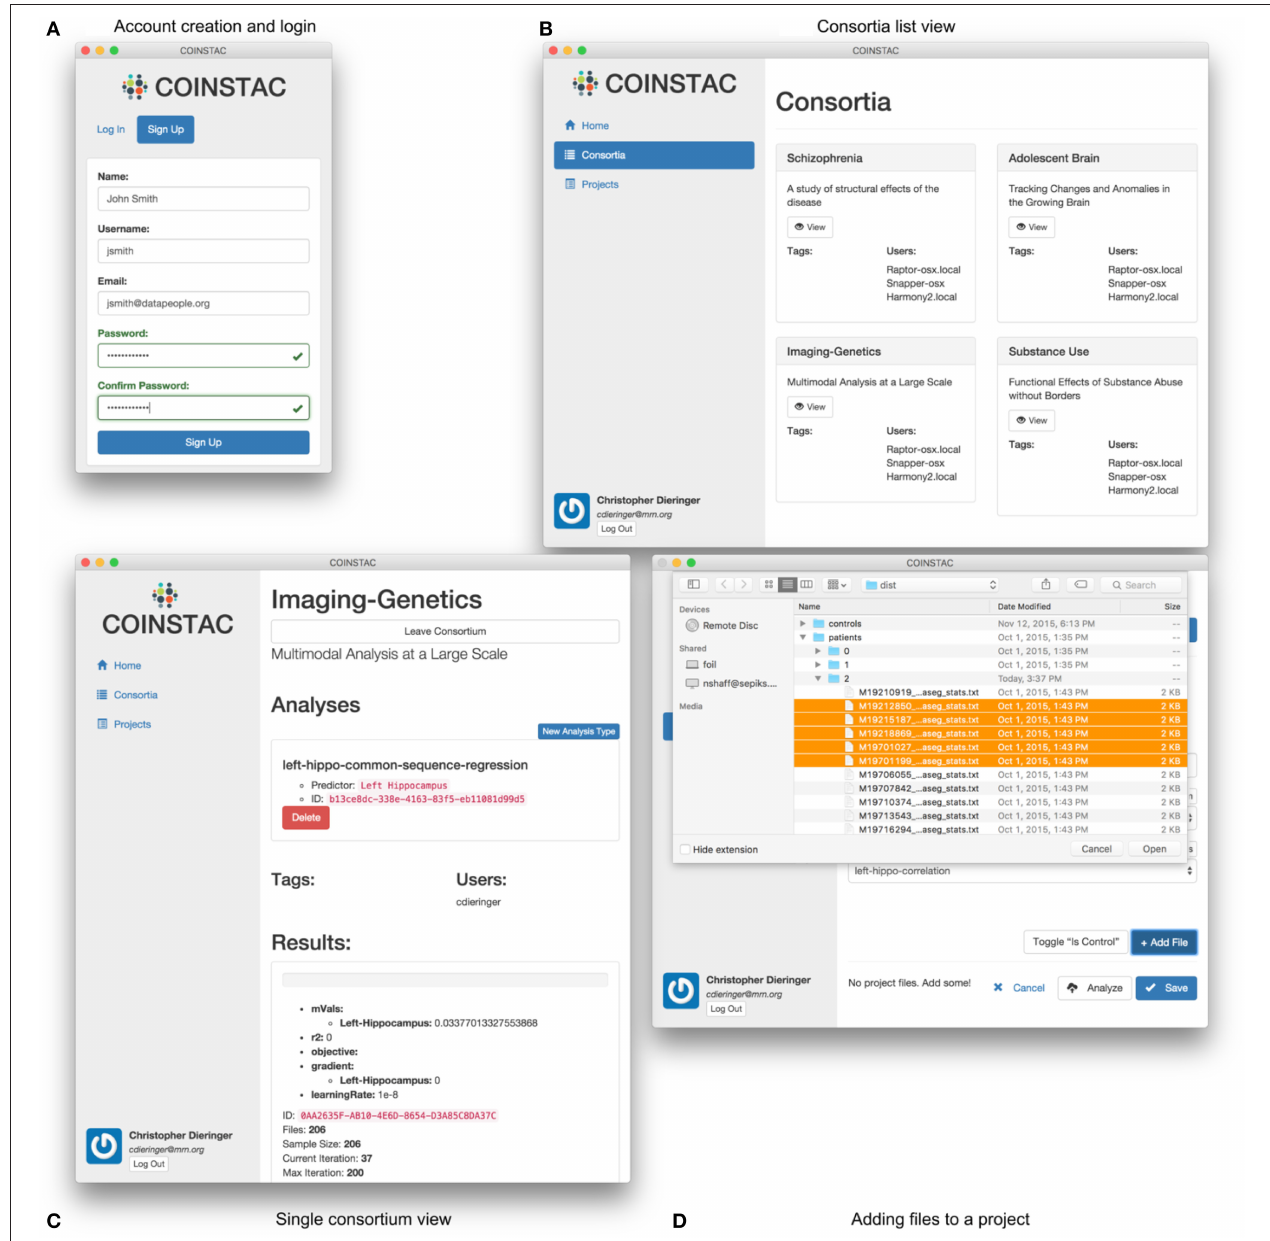
FIGURE 5 | User interface examples and parts of the COINSTAC workflow: (A) login to the system or account creation, (B) viewing (after creation) of the list of consortia the user is involved in, (C) view of a single consortium, and (D) adding files to a project within a consortium. Consortia list in (B) demonstrates a case of exercising a granular control: parts (or all) of a local data pool can be involved in different consortia (studies). At the same time, a data provider only allows their data to be used for the agreed-upon purposes of a consortium; to use these data for something else, a different consortium needs to be joined. The individual consortium view in (C) can show progress of ongoing computations and other monitoring information. Despite the client being essentially a web application, in COINSTAC it is straightforward to add data to a consortium using a simple point and click operation via standard OS tools with which the users are already